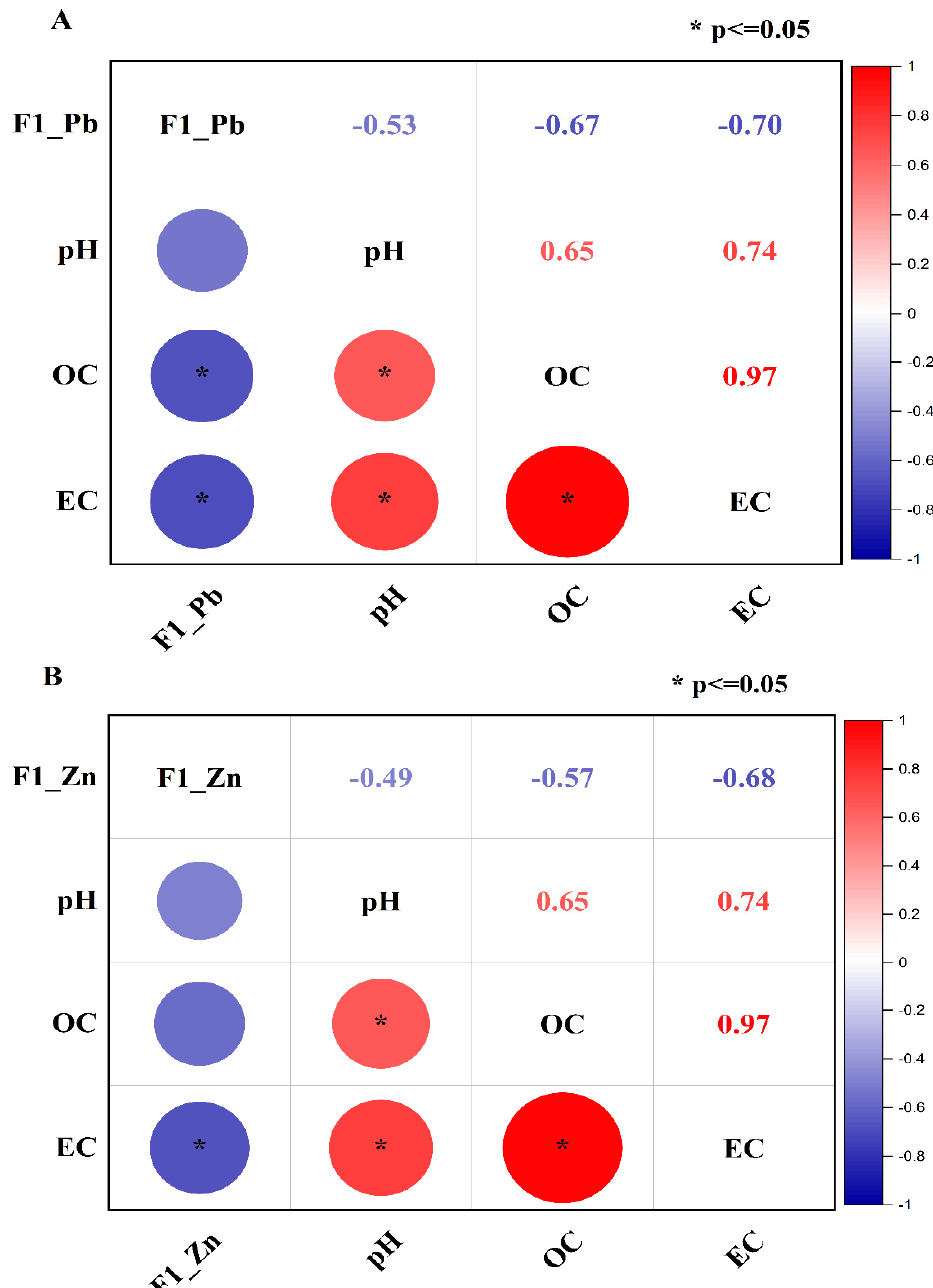
Figure 5. Correlation of pH, OC, and EC with F1, F2, F3, F4, and F5 of Pb ( A ) and Zn ( B ). (* p ≤ 0.05 indicates the level of the significant correlation) .